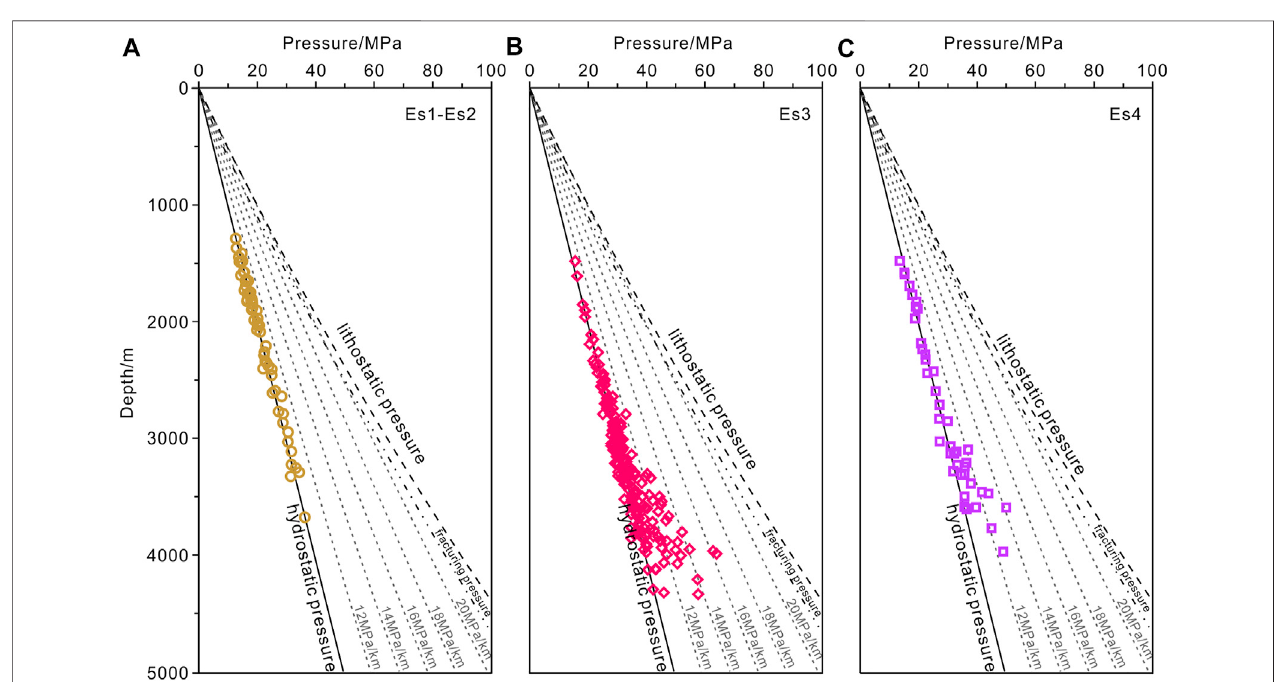
FIGURE 5 | Plots of measured pressures versus depth for Shahejie Formation in the Linnan Sag. (A) Es1-Es2, (B) Es3, and (C)